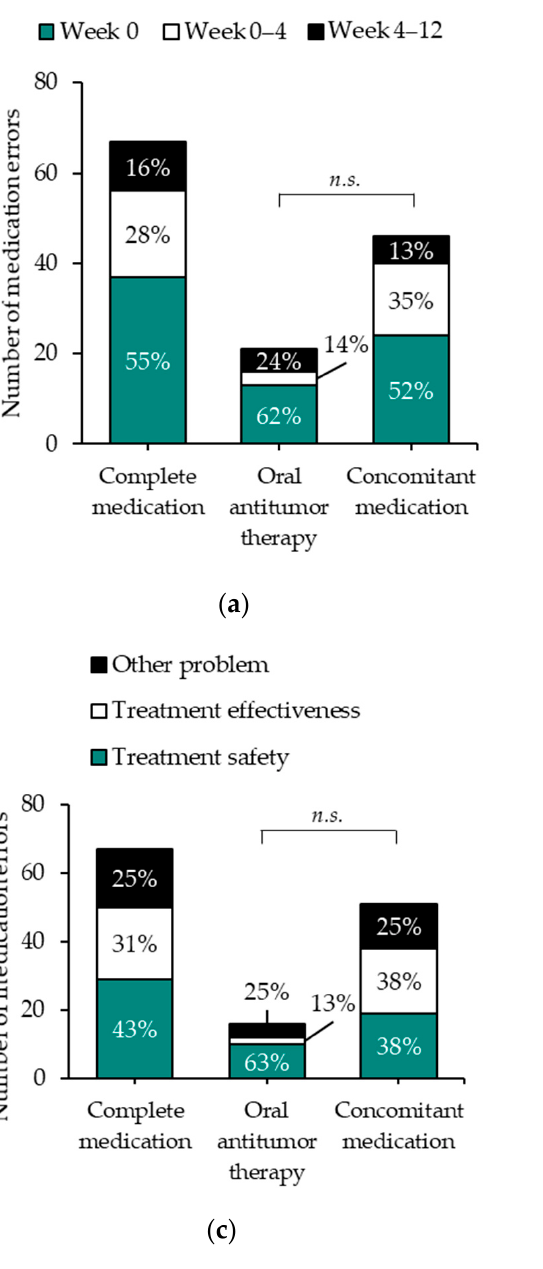
Figure 2. Number of medication errors in patients with PC or RCC treated with new oral antitumor drugs within the first 12 weeks of therapy stratified for ( a ) time point of occurrence; ( b ) patient as underlying cause, ( c ) type (anticipated consequence) of problem, and ( d ) harm categories according to the National Coordinating Council for Medication Error Reporting and Prevention (NCC-MERP index, [9]). Frequency distributions were analyzed using Pearson’s χ 2 -test and Fisher’s Exact test ( n.s. = not significant). + This contains NCC-MERP category ‘B’. * This contains NCC-MERP catego- ries ‘C’ and ‘D’. # This contains NCC-MERP categories ‘E’ to ‘I’. ** One patient suffered from consti- pation and inguinal hernia because he drank only half a glass of water per day, worrying to dilute abiraterone and thereby decrease therapeutic efficacy [14]; in another patient, therapy with nitrendipine was insufficient after he received enzalutamide (strong inducer of CYP3A4) resulting in hypertension; in the third case, the international normalized ratio (INR) of a patient under treat- ment with phenprocoumon decreased over time after therapy initiation of enzalutamide (strong inducer of CYP2C9) resulting in insufficient anticoagulation (INR 1.46 after 3 months).